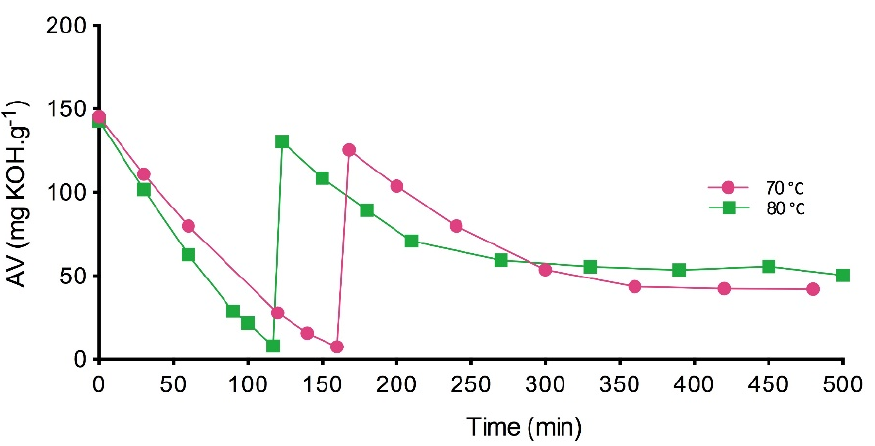
Figure 3. Acid value (AV) with time at 70 ◦ C and 80 ◦ C in a fed-batch reactor (stepwise acid addition after consumption), 350 rpm, 2.5% (w/w) of biocatalyst and a substrate molar ratio of 1:1.